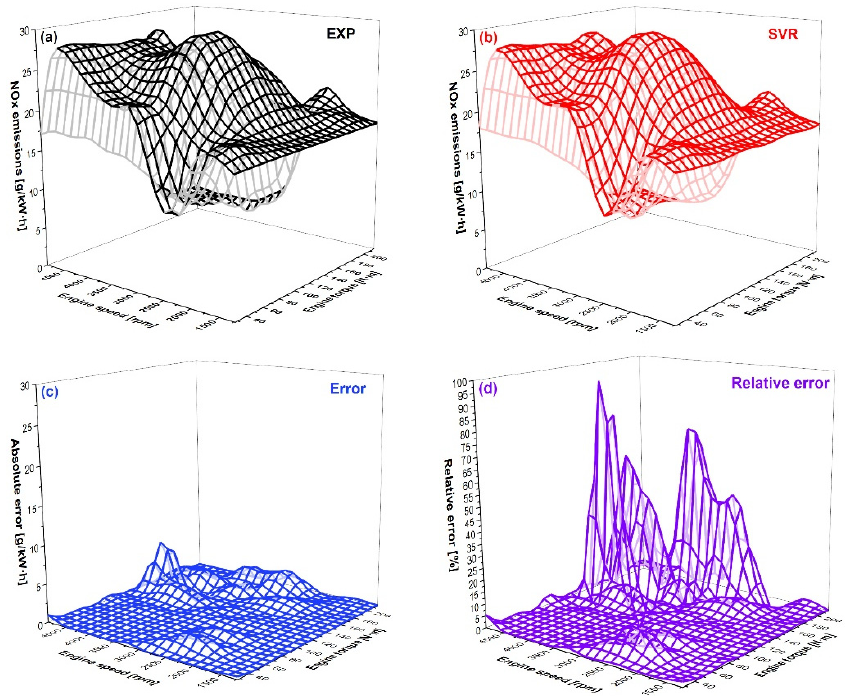
Figure 14. Comparison of SVR-predicted and experimental NOx-emissions-established engine map. ( a ) The experimental data; ( b ) The SVR-predicted data; ( c ) The absolute error; ( d ) The relative error.